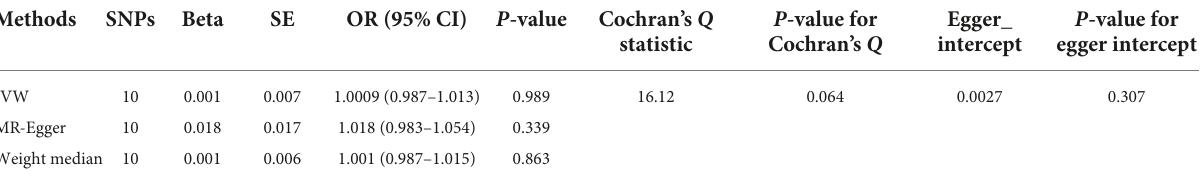
TABLE 2 Mendelian randomization (MR) analyses effect estimates for association between calcific aortic valvular stenosis (CAVS) and risk of telomere length (TL).